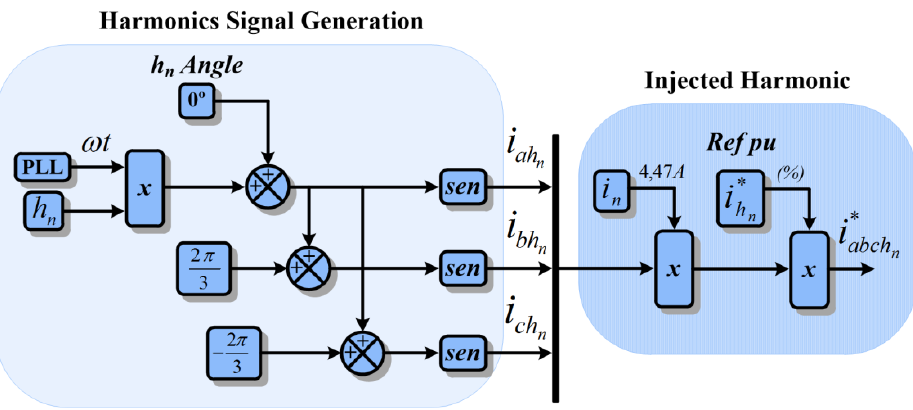
Figure 9. Block diagram of current harmonics generator.